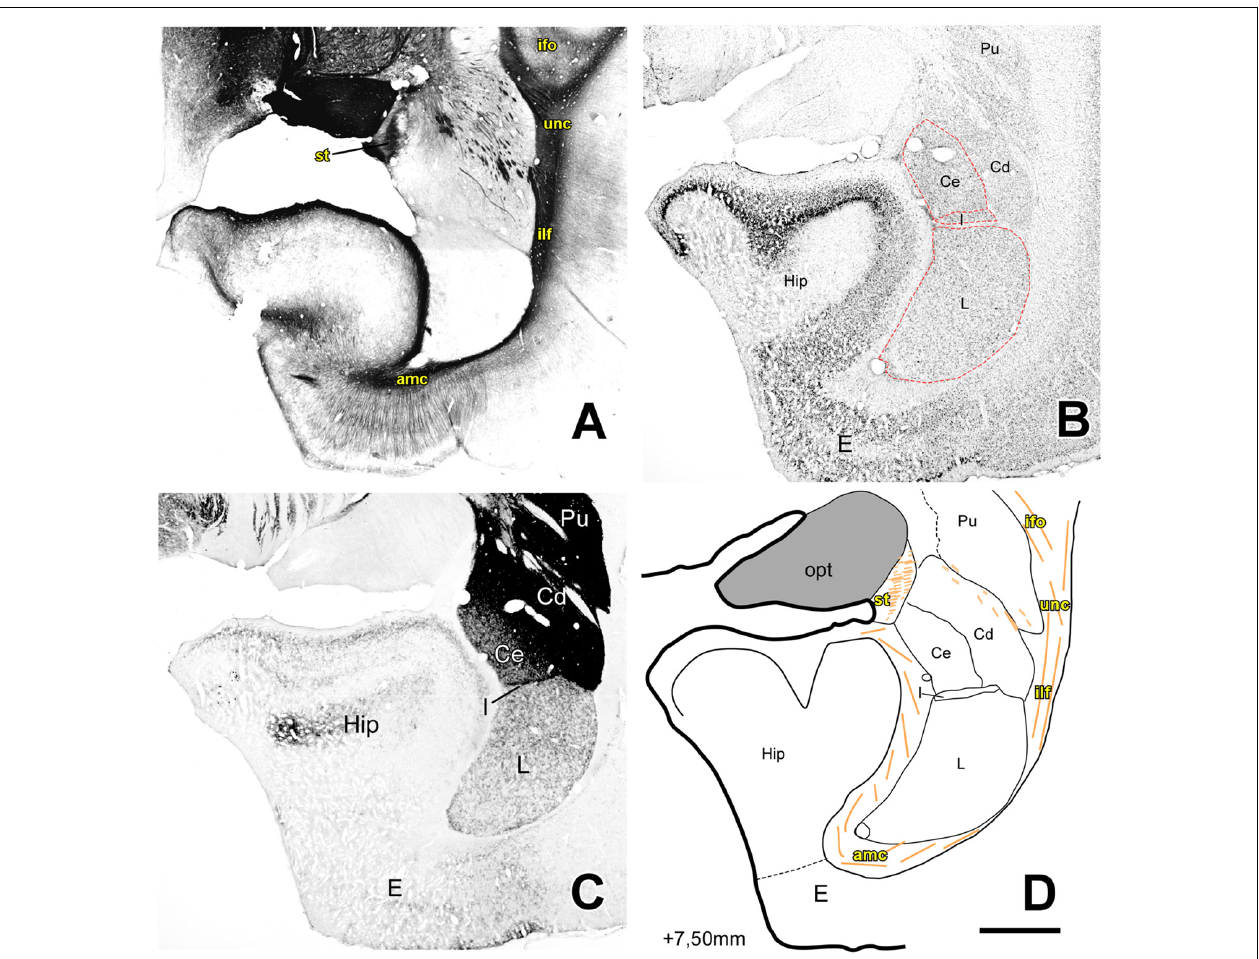
FIGURE 5 | Myelo- and cytoarchitecture, level 5 (Interaural 7.50 mm). Series of adjacent coronal sections stained for Gallyas (A) , Nissl (B) and AChE (C) and the corresponding drawing showing in black the territories of the AC and in orange the myelinic bundles schematically (D) . Unambiguous nuclear boundaries are drawn with a red dashed line. At this level, the Hip shows a bigger volume than the AC and only the L, Ce, I and Me nuclei were present. At this level, STIA is adjacent to the opt and a strongly AChE stained I separated the Me and Ce nuclei from the L. Scale: 1